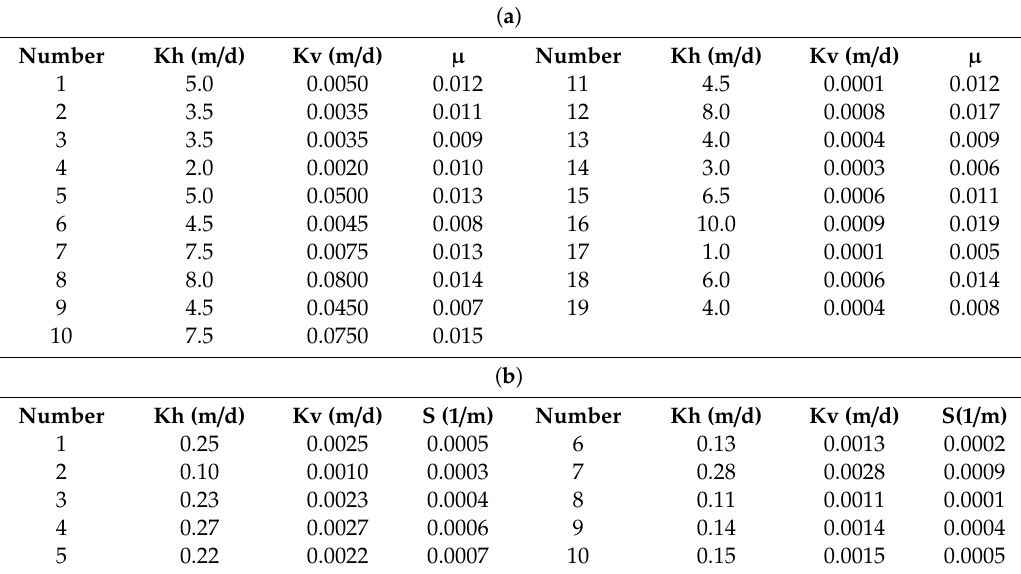
Table 1. ( a ) Hydrogeological parameter values of the first aquifer; ( b ) hydrogeological parameter values of the second aquifer.